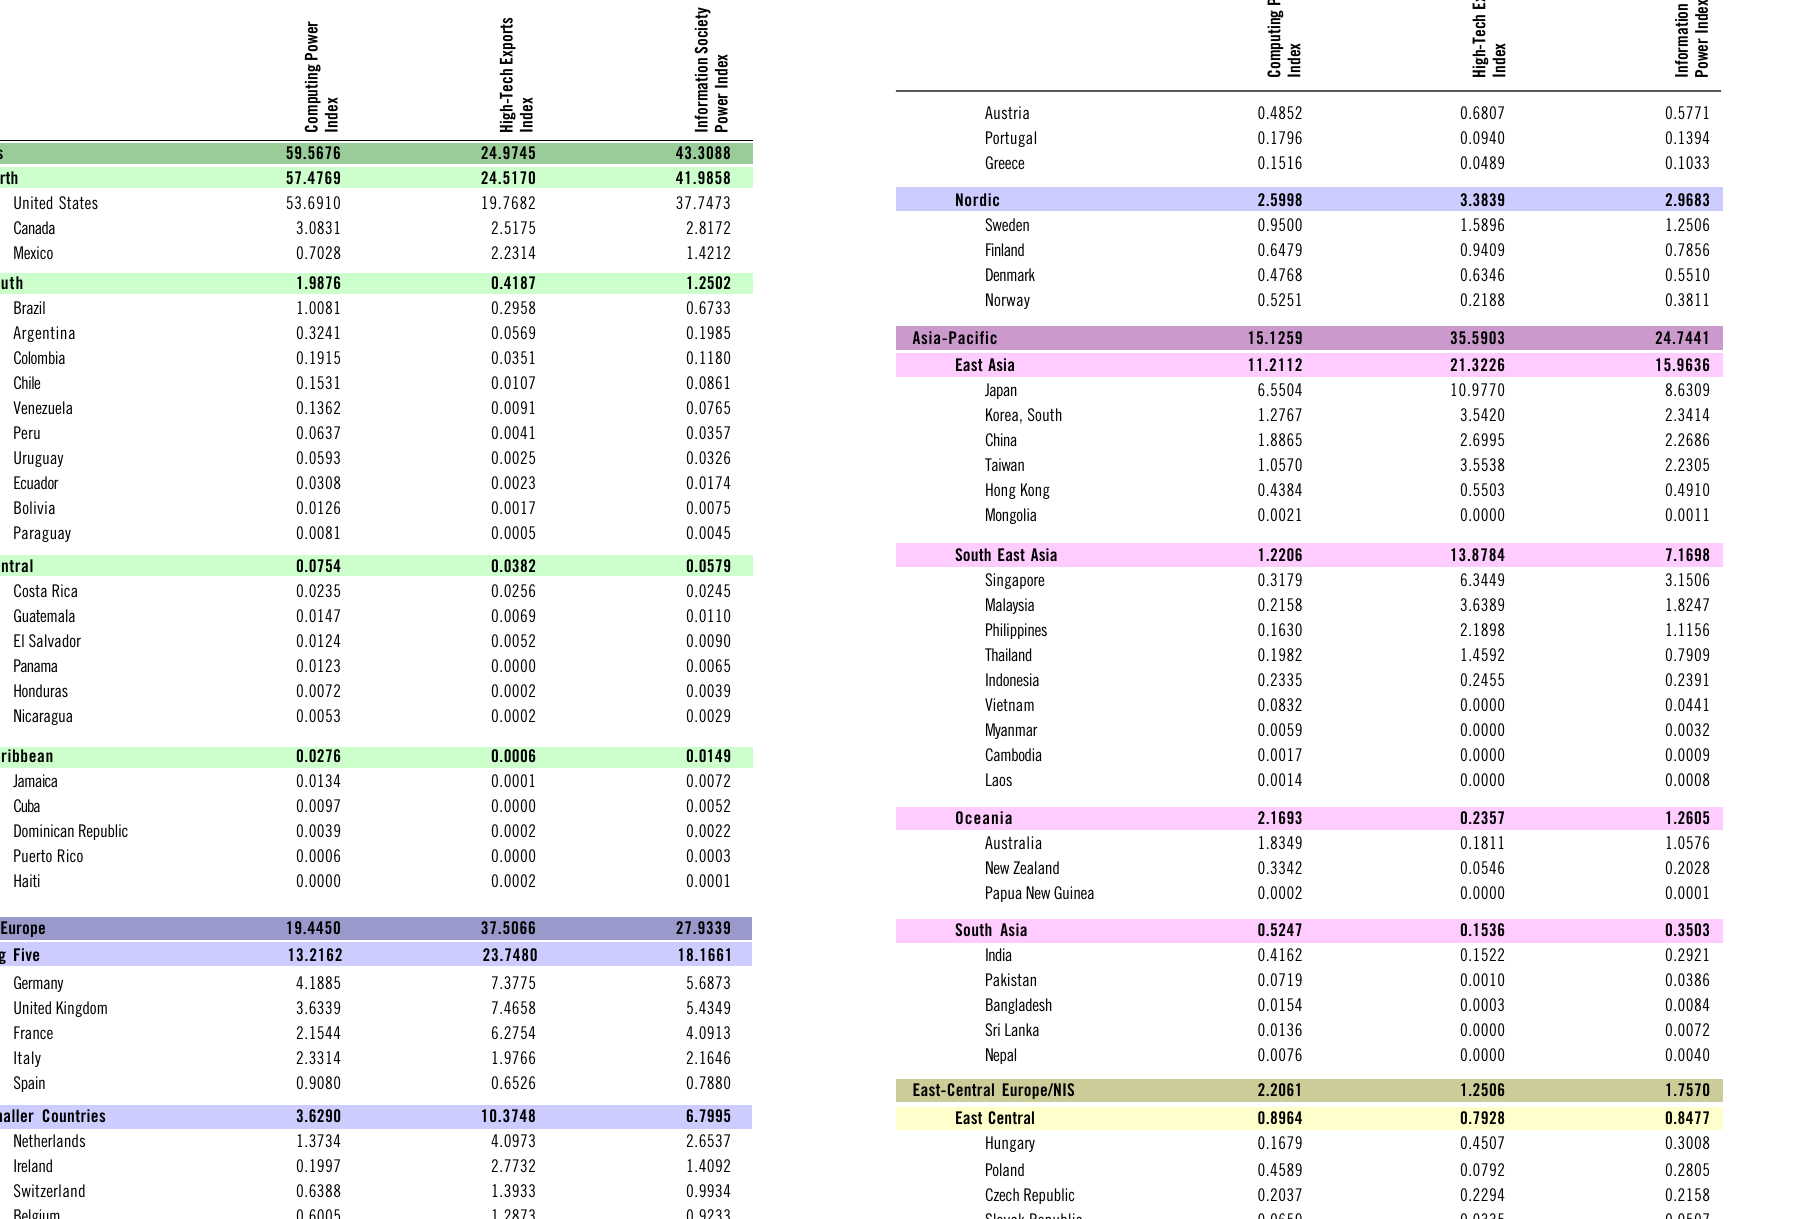
Table 7 – Relative Standing of Countries within Subregions of Major World